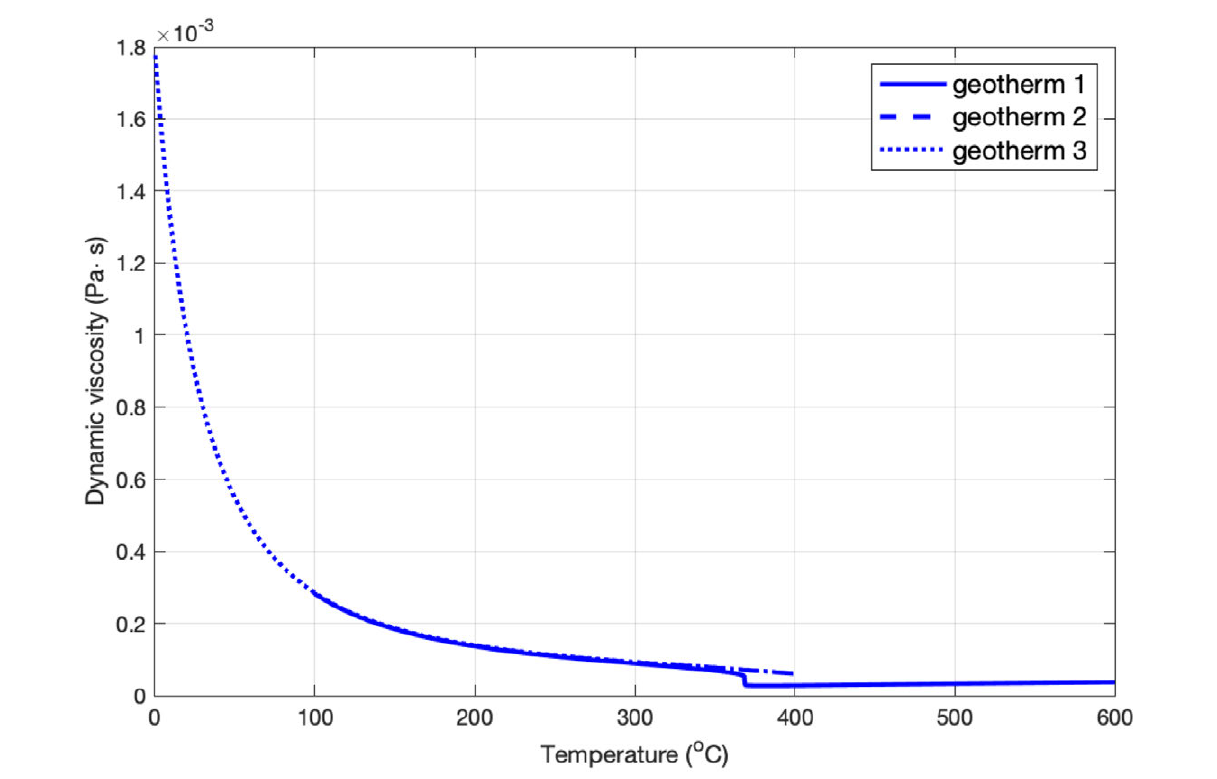
Figure D8: Dynamic viscosity of water as a function of temperature for the same 3 geotherms as in Figure D5. Data from Parry et al.